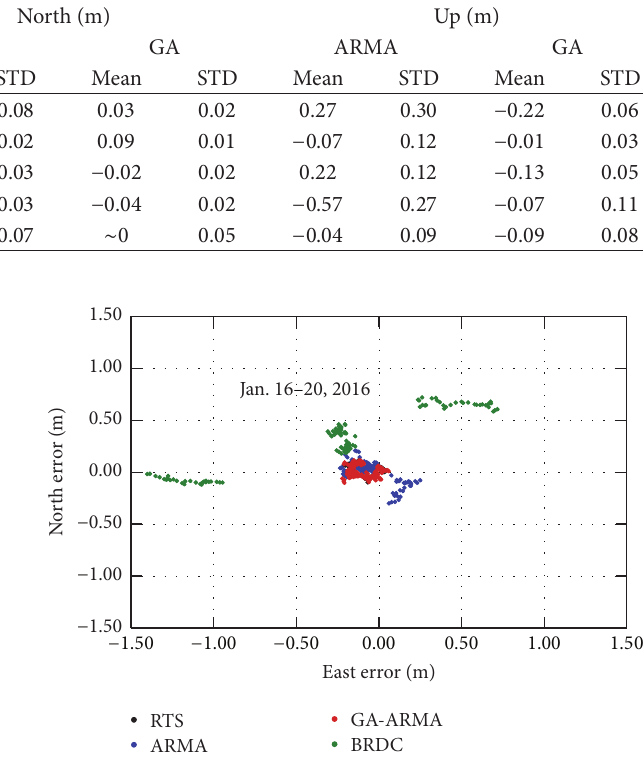
Figure 9: Estimation result of the horizontal and vertical errors (January 16–20,